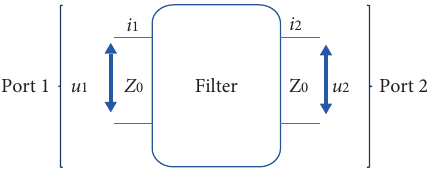
Figure 3: Schematic diagram of the